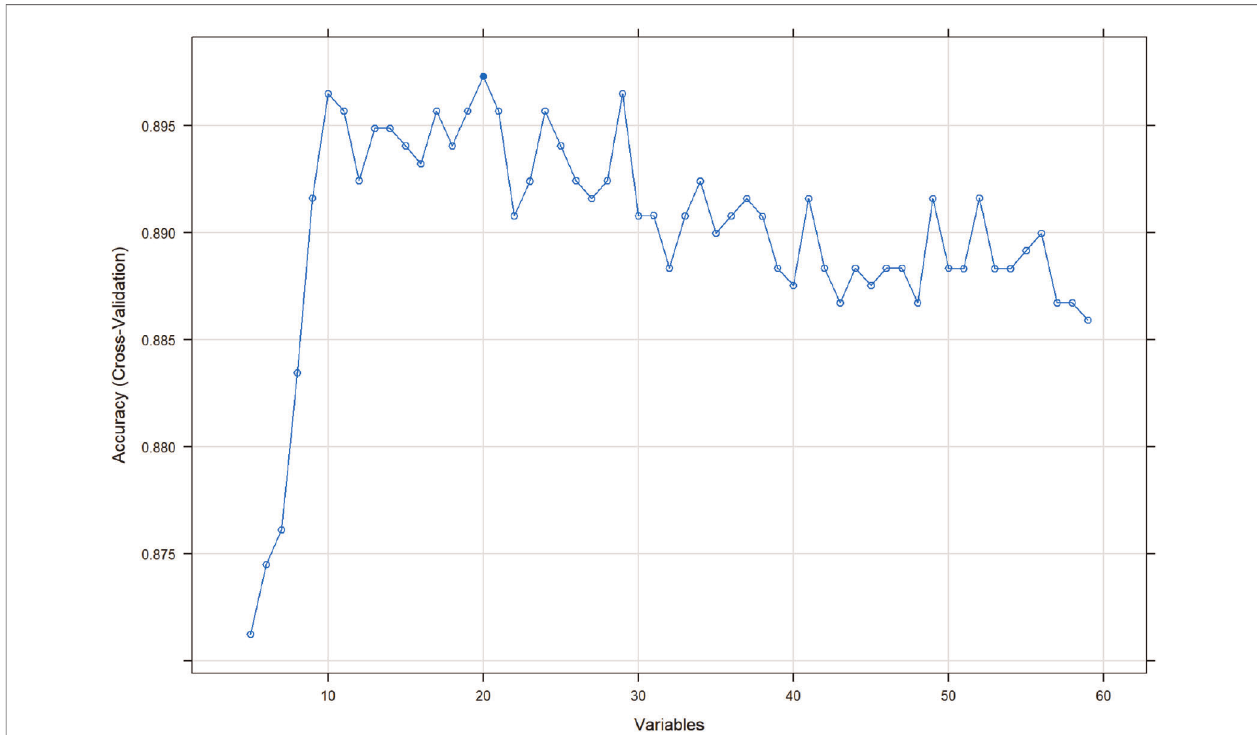
FIGURE 2 | Correlation diagram between different feature numbers and accuracy in the RFE algorithm. RFE, recursive feature elimination.